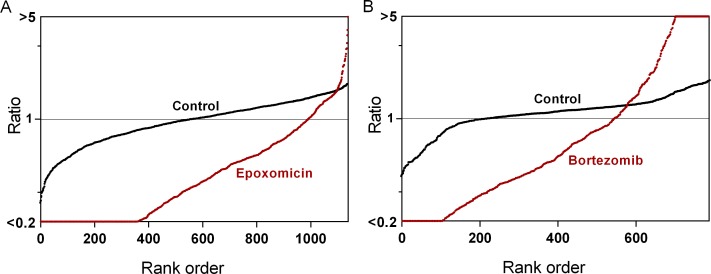
Summary plots of the peptidome of Q7Q7 cells in response to proteasome inhibitors.A: Cells were treated with 200 nM epoxomicin for 1 hour. B: Cells were treated with 500 nM bortezomib for 1 hour. The relative levels of all peptides identified by MS/MS analysis in each of the inhibitor-treated replicates was compared to the average level of the peptide in the untreated control replicates. The y-axis represents the relative peptide levels (log-scale) and the x-axis represents the rank order of peptides sorted according to the relative level. If the ratio was <0.20 or >5.0, the value was capped at 0.20 or 5.0 to reflect the typical signal to noise ratio. Red circles indicate the ratio of each replicate of identified peptides in inhibitor-treated cells, expressed relative to the average control value. Black circles indicate the ratio of each control replicate expressed relative to the average control value.